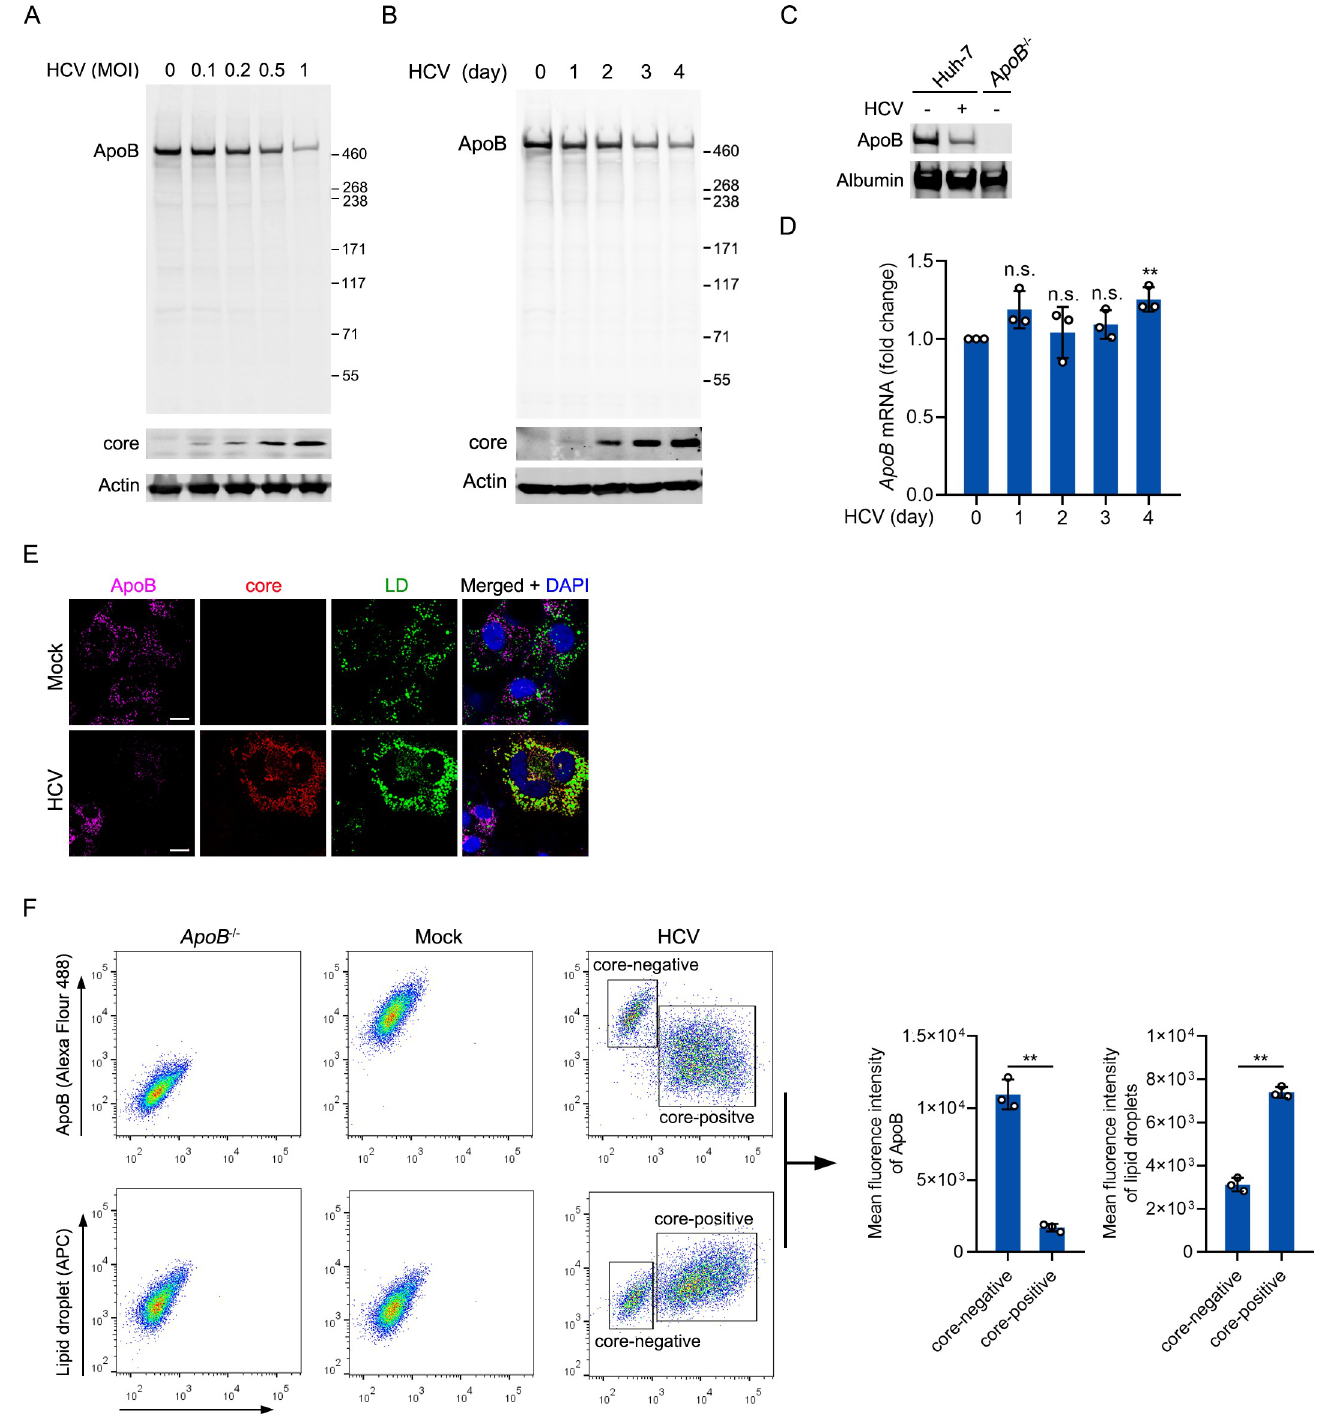
Fig 1. The protein level of ApoB was decreased in HCV-infected cells. (A) Huh-7 cells were infected with HCV at different MOIs. After 96 hours, the protein levels of ApoB and HCV core proteins were analyzed by western blotting. Actin was used as the loading control. (B) Huh-7 cells were infected with HCV (MOI = 1). The protein levels of ApoB and HCV core proteins were analyzed by western blotting at the indicated timepoints after infection. Actin was used as the loading control. (C) The protein level of ApoB in culture supernatants of mock-infected, HCV-infected (MOI = 1) Huh-7 cells or ApoB -/- cells was analyzed by western blotting at 4 days post infection. Albumin was used as the loading control. (D) qPCR analysis of the mRNA level of ApoB in cells in B. The results are presented as fold changes in the mRNA level of ApoB relative to that of GAPDH . (E) Immunostaining was performed with anti-ApoB and anti-core antibodies in